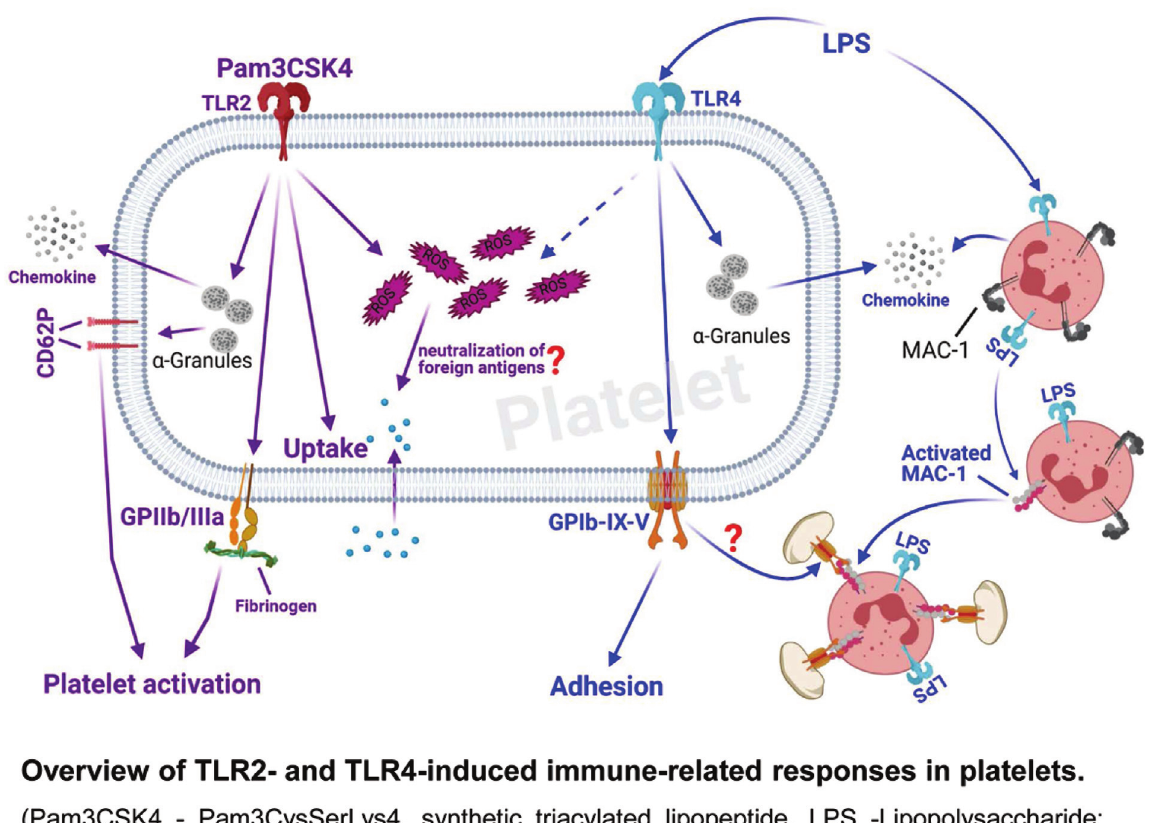
Fig. 7 Visual summery. TLR, toll-like